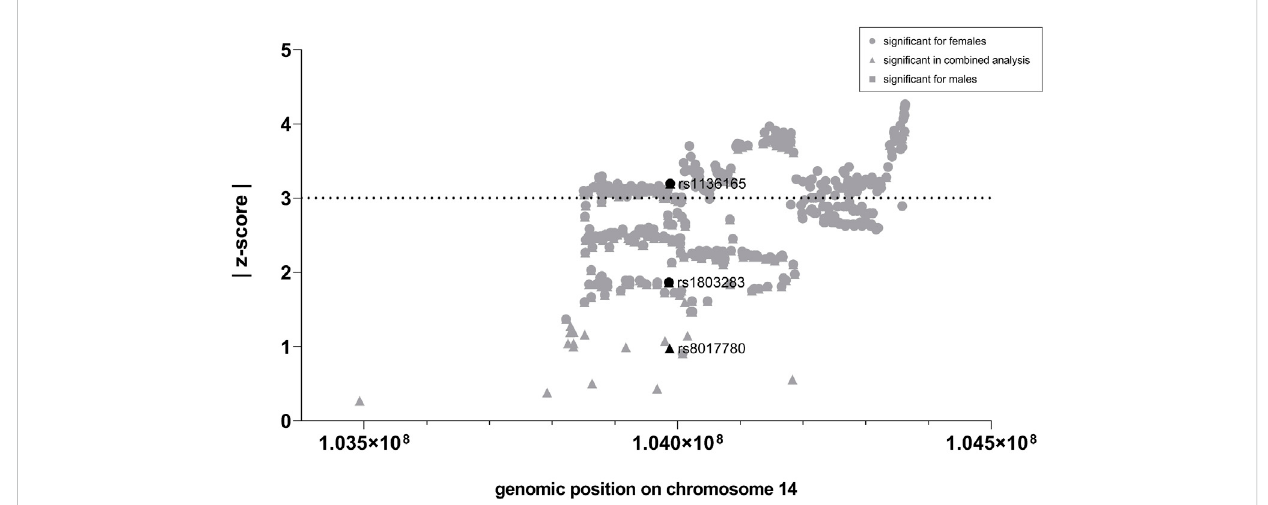
Z-scores for BMI-associated SNPs located in CKB and the 500 kb adjacent region. Here, the absolute z-scores were plotted against the chromosomalpositionofeachSNP(GRCh37).Aftertheextractionofthesex-strati fi edBMIGWASdata(Pulitetal.,2019),ambiguousSNPswereremoved. Subsequently, the effect directions were harmonized, and the z-scores were calculated for each genome-wide and thus BMI-associated SNP within the region of CKB (black) and its 500 kb surrounding region (gray). A SNP is considered sex-dimorphic if |z-score| ≥